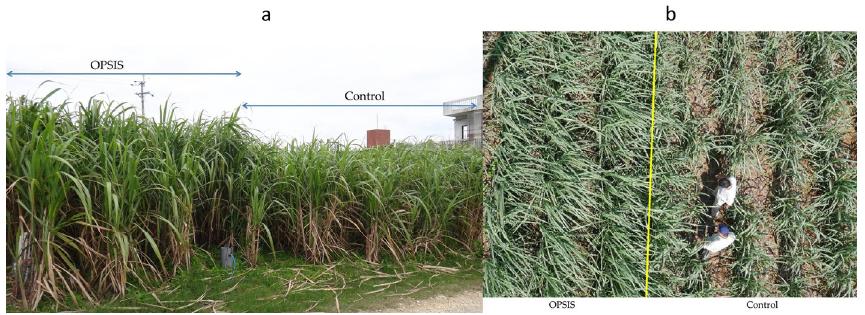
Figure 10. Growth of sugarcane with OPSIS and rainfed conditions ( a ) Plant height, ( b ) Canopy cover.